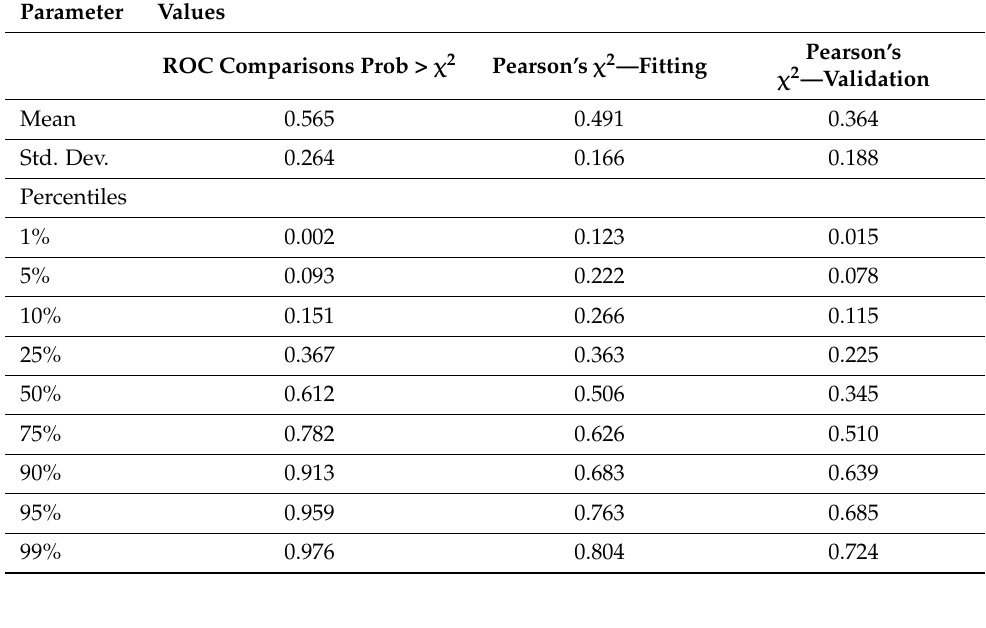
Table 10. Distribution of performance measures—firm pooled model validation.